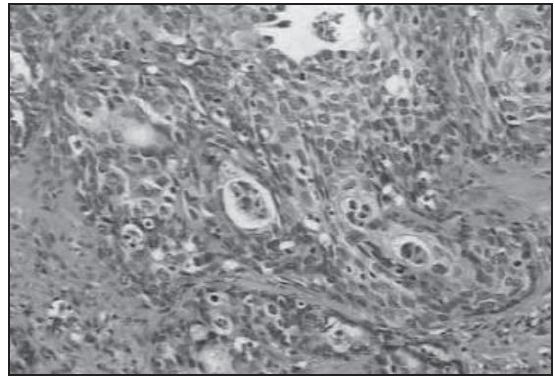
Figura 4 – Região intermediária da neoplasia: observa-se diferenciação escamosa e glandular (HE, 100x)